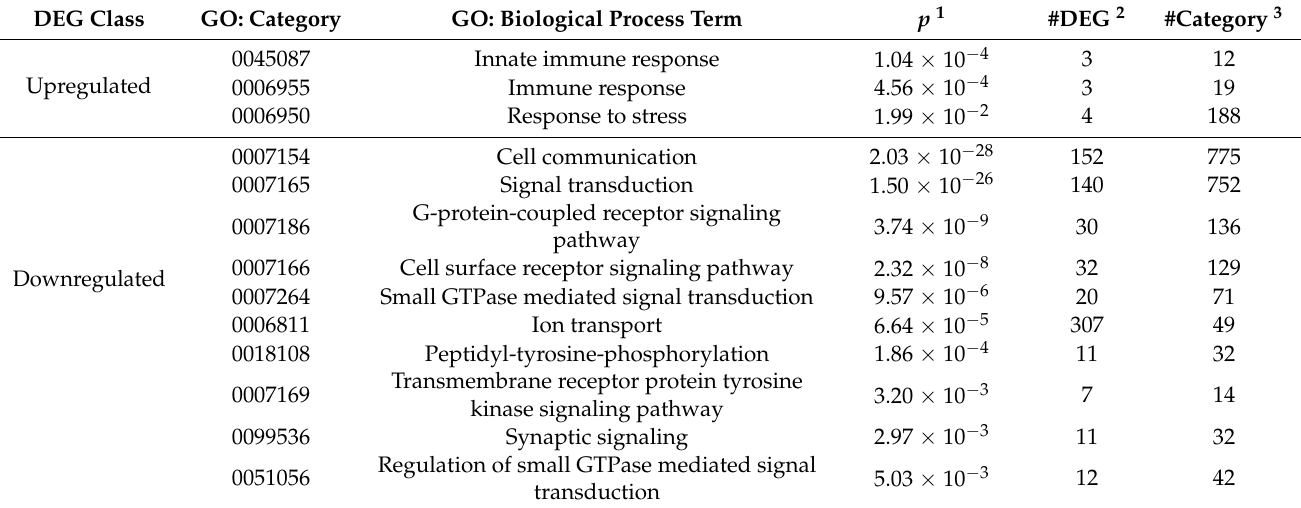
Table 2. Selected biological processes enriched in upregulated or downregulated differentially expressed genes (DEGs). DEG Class GO: